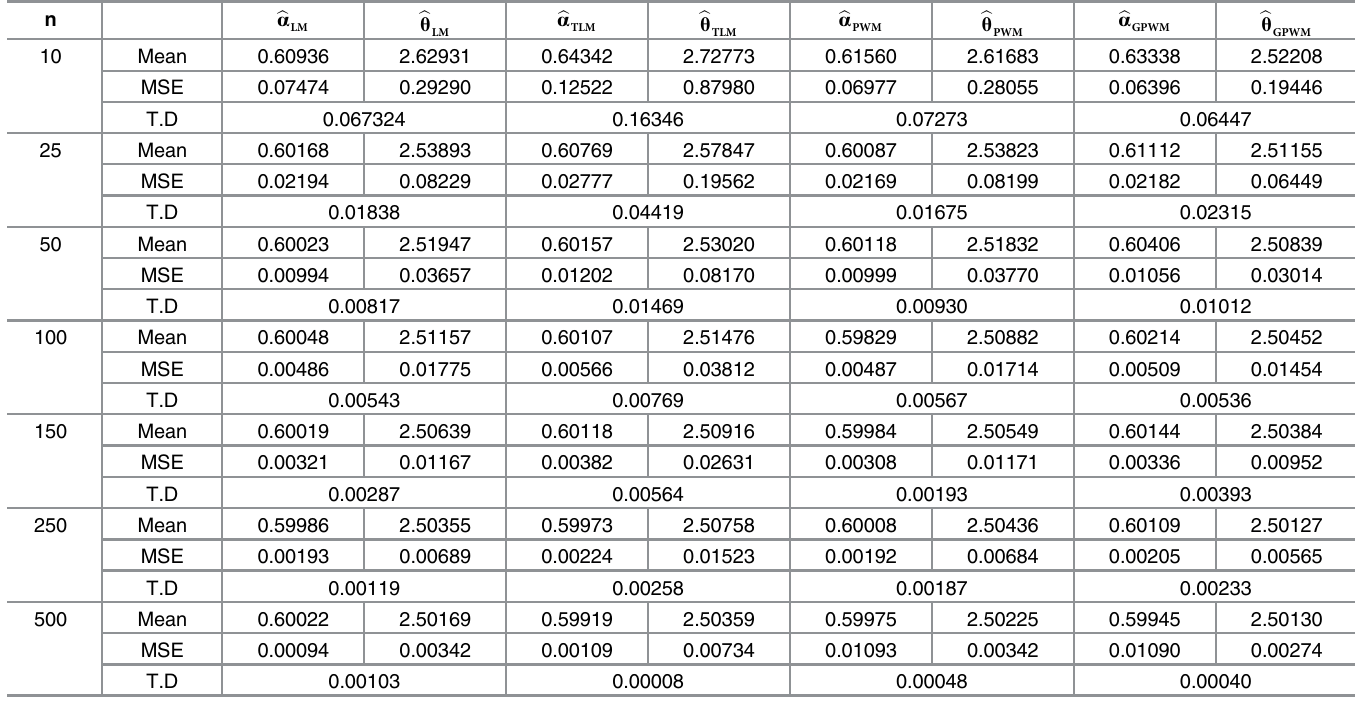
Table 1. Comparison of the estimation methods for ( α = 0.6, θ =